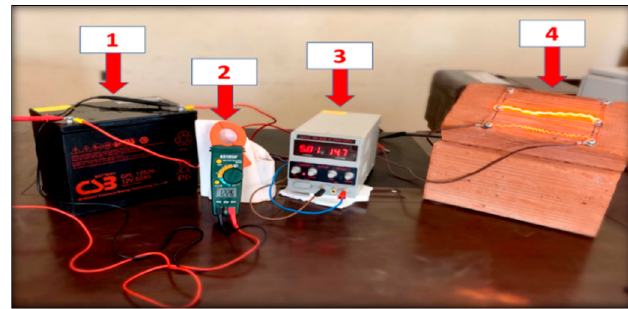
Figure 5. The test bench.